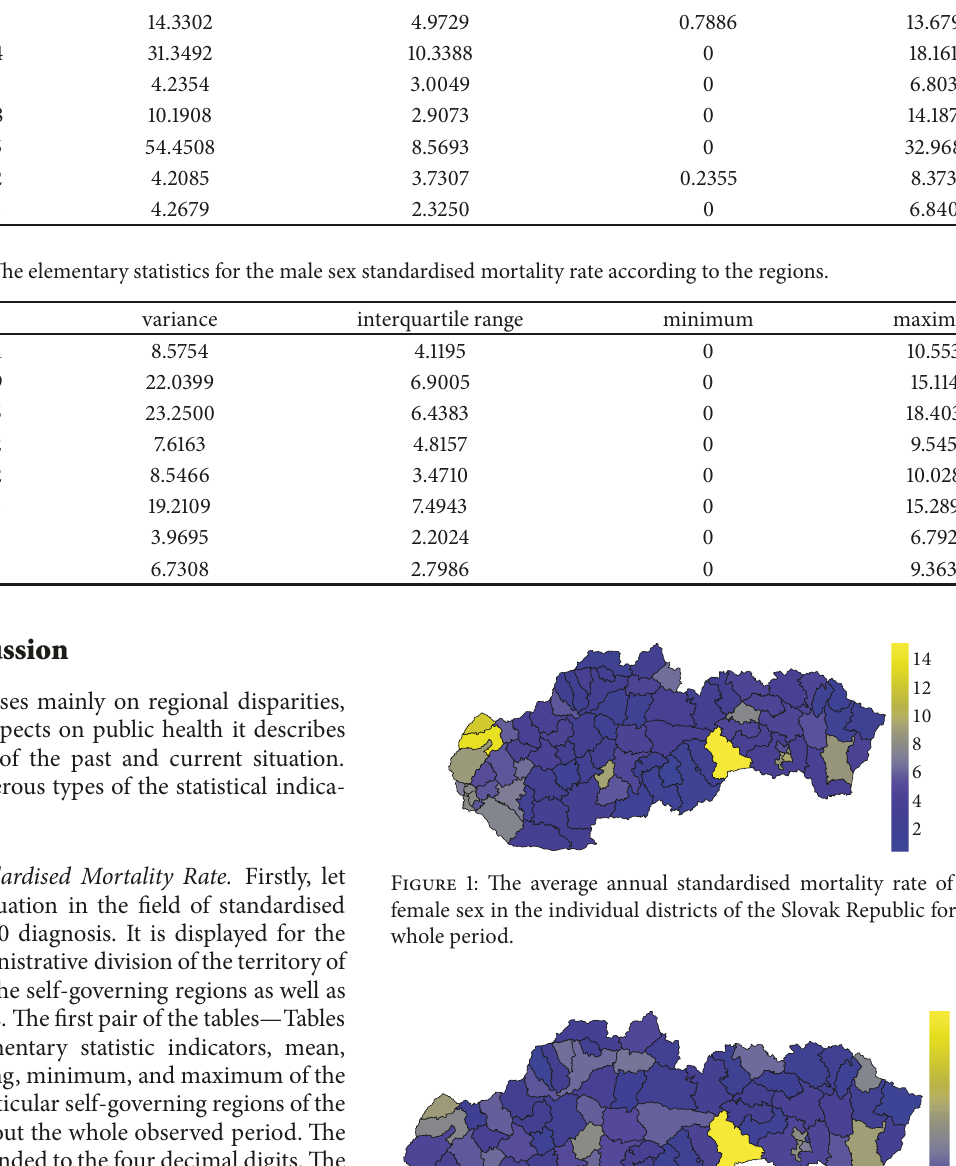
Table 1: The elementary statistics for the female sex standardised mortality rate according to the regions. district